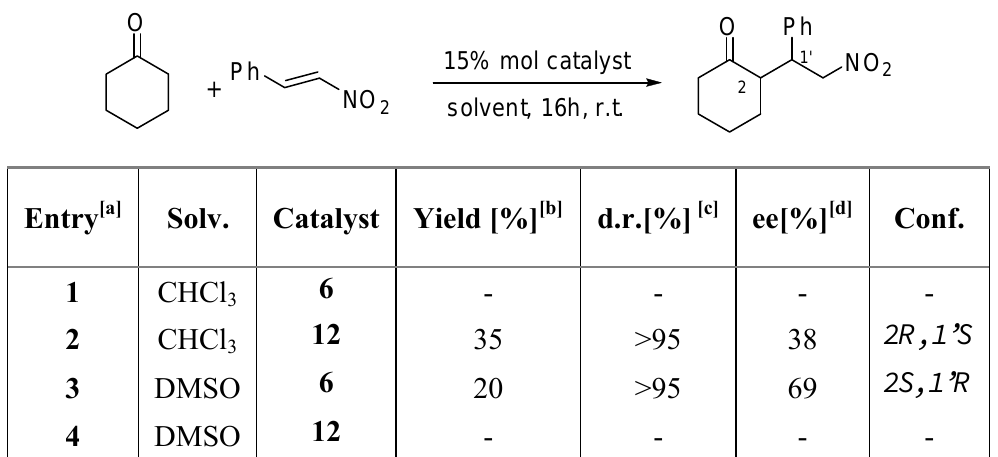
Table 2. Solvent effects on the asymmetric Michael addition of cyclohexanone to trans -  - nitrostyrene with catalysts 6 and 12